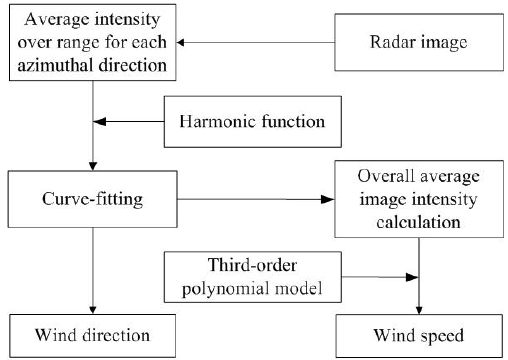
Figure 4. Basic steps of the single-Curve Fitting (CF) method for wind direction and speed